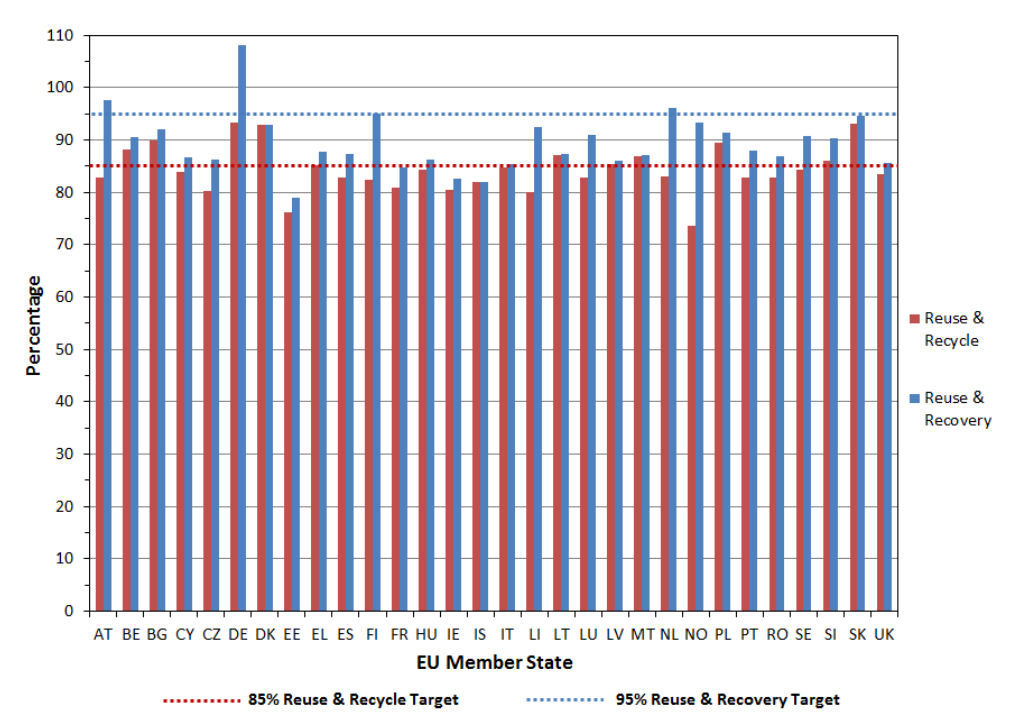
Figure 3. End-of-life vehicle (ELV) recovery and recycling rates reported by EU member states for 2011